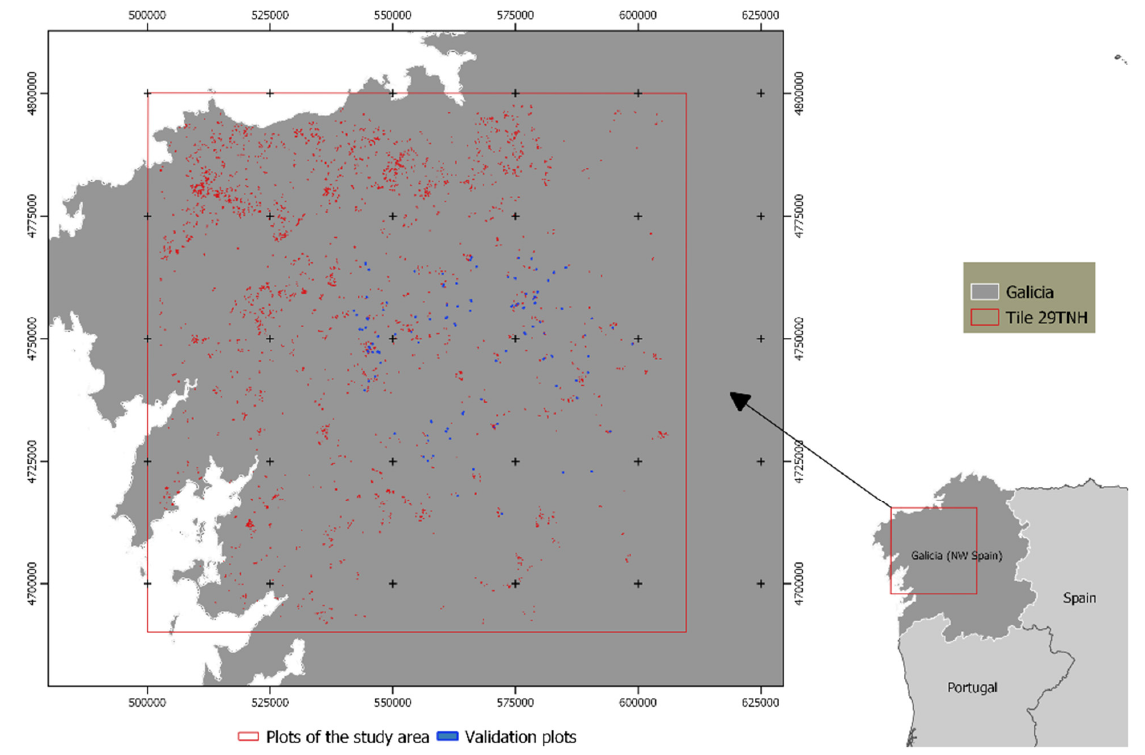
Figure 1. Analyzed plot distribution in Galicia (NW Spain). Coordinate system ETRS89-UTM29T.